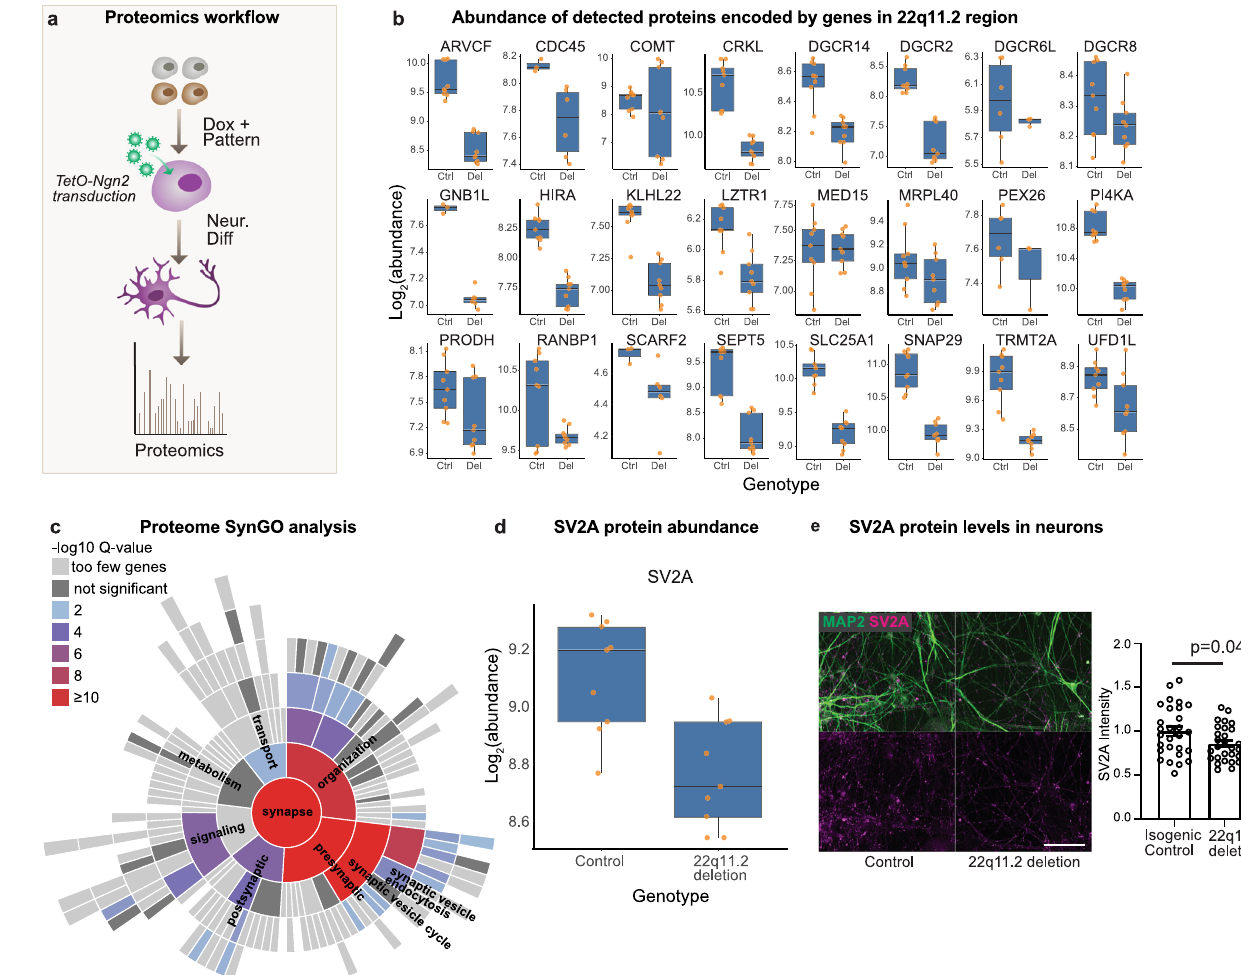
Fig. 6 Whole cell proteomics on 22q11.2 deletion neurons. a Work fl ow schematic. Neurons from deletion carriers and controls were harvested 28 days post neuronal induction. b Abundance of proteins encoded by genes in the 22q11.2 region detected by proteomics in neurons. Del = 22q11.2 deletion. Ctrl = control. (N(cases) = 2, N(controls) = 2, total 18 replicates). Data is presented in a Tukey style boxplot with the median (Q2) and the fi rst and the second quartiles (Q2, Q3) and error bars de fi ned by the last data point within + / − 1.5-times the interquartile range. c Synaptic gene ontologies (SynGO) in proteins downregulated in deletion carrier neurons. d SV2A protein levels detected by proteomics are decreased in deletion carrier neurons. N(cases) = 2, N(controls) = 2, total 18 replicates). Data is presented in a Tukey style boxplot with the median (Q2) and the fi rst and the second quartiles (Q2, Q3) and error bars de fi ned by the last data point within + / − 1.5-times the interquartile range. e SV2A protein levels detected by antibody staining are decreased in day 28 neurons derived from isogenic lines with 22q11.2 heterozygous deletion compared to controls. (Left) Representative confocal images of control and 22q11.2 deletion neurons stained with antibodies against SV2A (magenta) and MAP2 (green). Scale bar is 100 µ m. (Right) Quanti fi cation of total SV2A fl uorescence within MAP2-positive neurites normalized to isogenic controls. Data are means ± SEM. Individual points are analyzed fi elds of view from 4 independent inductions per condition. Statistical analysis by two-sided Student ’ s t -test reveals statistically signi fi cant ( p = 0.037) decrease in SV2A levels in deletion